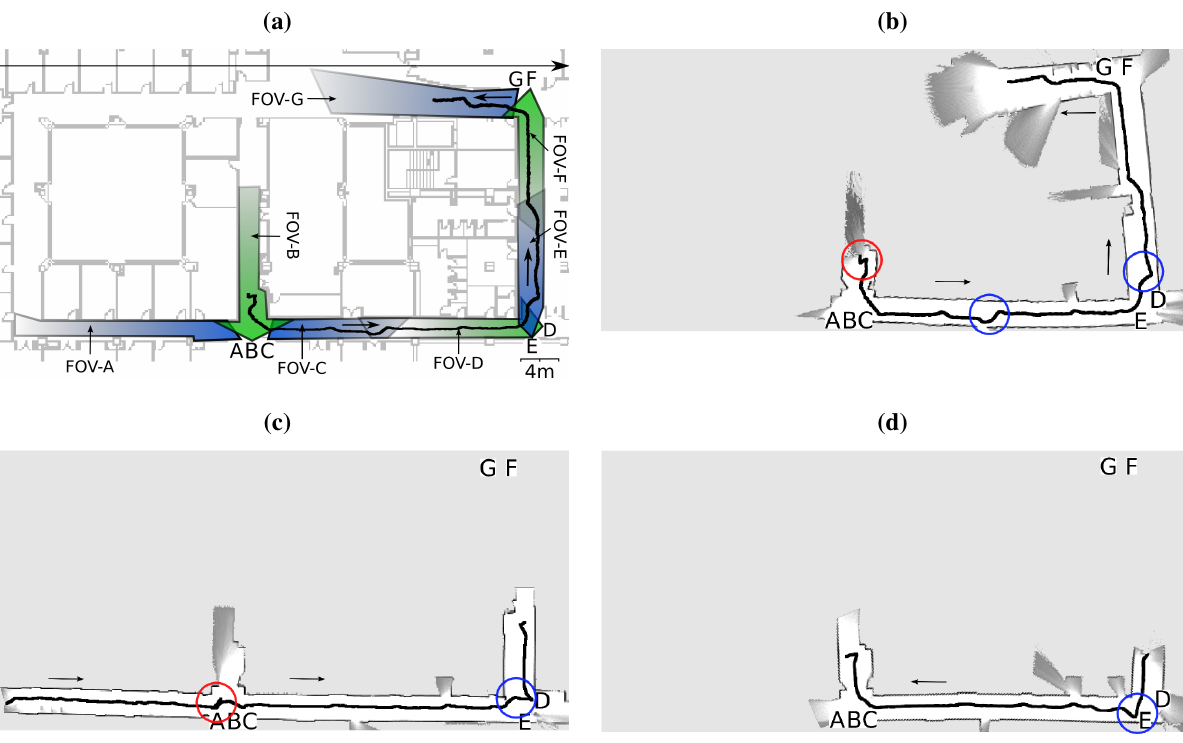
Figure 12. ( a ) Camera network deployed in the experiments. Each camera is represented by a letter (from A to G), and each FOV is represented by a coloured region. The trajectory represented is the same as in (b). ( b ) Robot trajectory through the route B-C-D-E-F-G (70 m long). ( c ) Robot trajectory through the route A-B-C-D-E (60 m long). ( d ) Robot trajectory through the route E-D-C-B ( 50 m long). We provide explanations of each trajectory in the